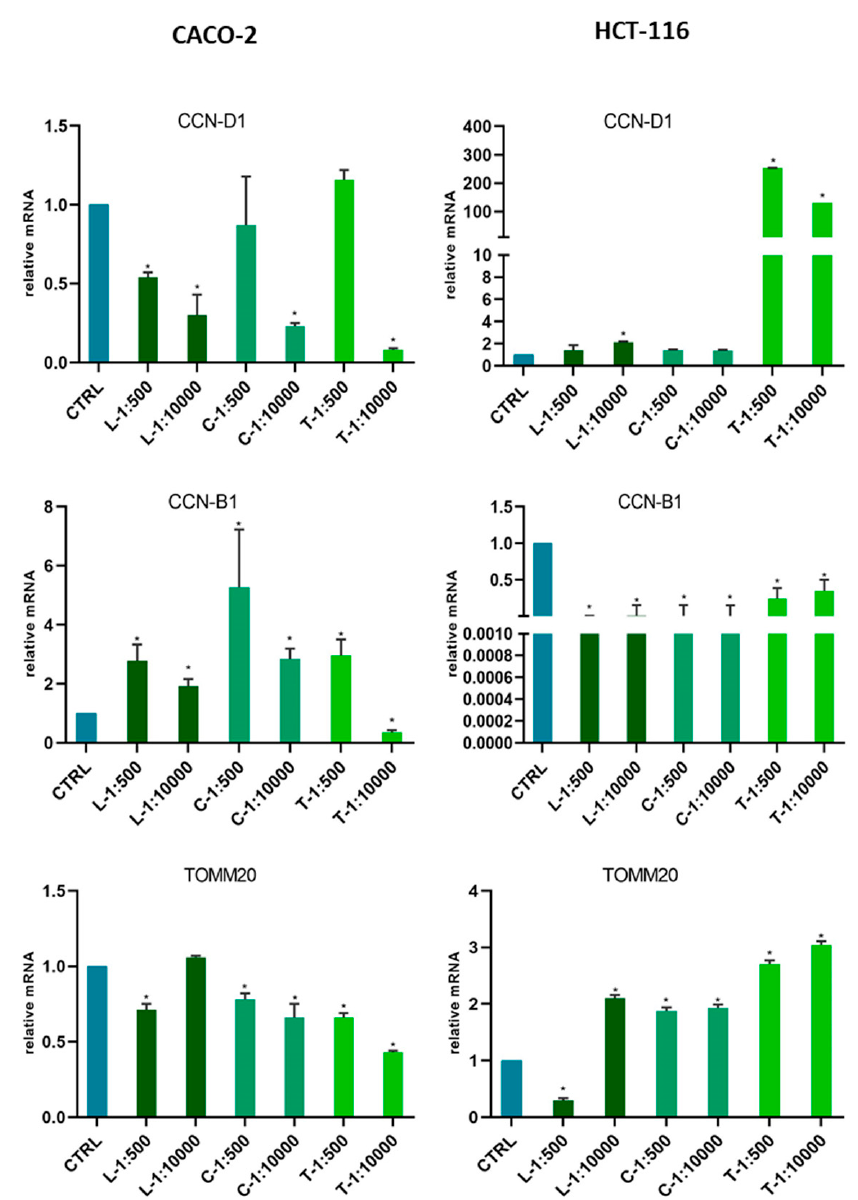
Figure 6. Gene expression modulation under Extract treatments in colon cancer cells Caco-2 and HCT116. Gene expression was analyzed by Real Time-qPCR. The histograms represented normalized data with GUSB gene, and the results showed the average of three independent experiments. CCN-D1 (Cyclin D1); CCN-B1 (Cyclin B1); TOMM20 (Translocase of outer mitochondrial membrane 20). * p < 0.05 vs. untreated cells.